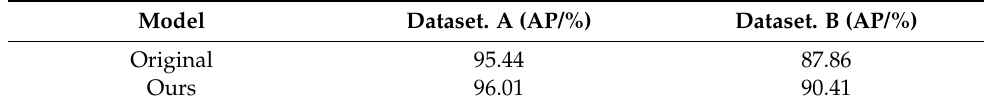
Table 3. Comparison of citrus fruit data sets with different occlusion